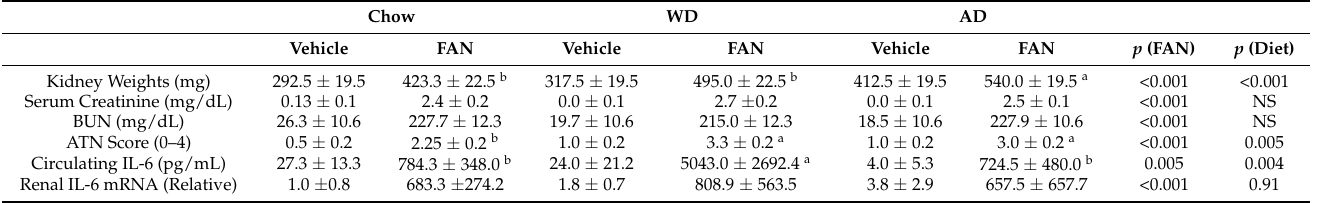
Values are presented as mean ± SEM, n = 4 for all groups. Different superscript letters (a vs. b) signify significant difference between diets ( p < 0.05) as determined by Two-Way ANOVA with Tukey Post Hoc test. Treatments with similar superscript letters are not statistically different ( p > 0.05). NS = no significant difference ( p > 0.1).